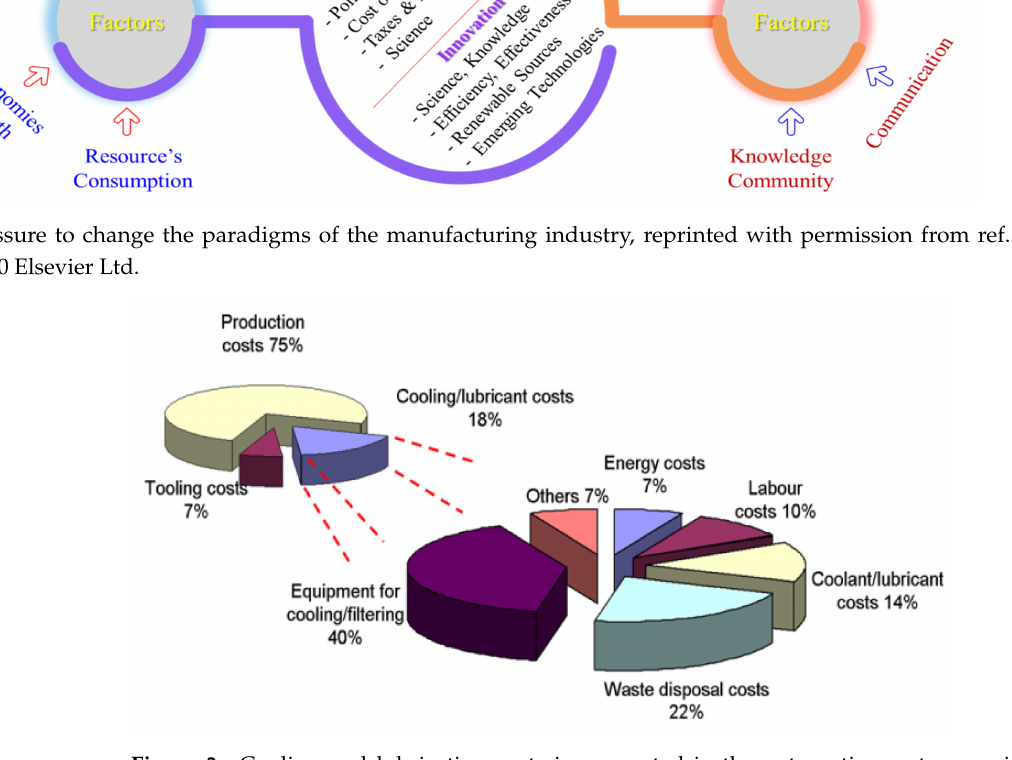
Figure 3. Cooling and lubricating costs incorporated in the automotive sector, reprinted with permission from ref. [31]. Copyright 2010 Elsevier